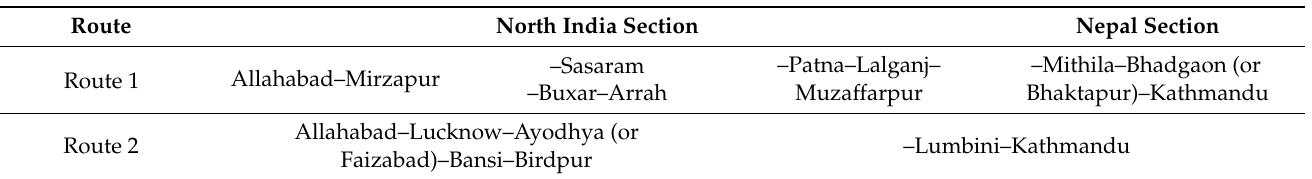
Figure 7. Inferred transportation routes in the middle and lower Ganges Valley and adjoining regions as from the 16th century to the mid-18th century. Source: the authors; Base Map: Google satellite map; Reference: [52] (pp. 45–48), [66] (pp. 40–41, 62–63, 76–79, 85–86). Table 2. Inferred routes from the Middle Ganga Plain to China’s Tibet via Nepal (16th to the mid-18th century). Reference: [31] (p. 64).